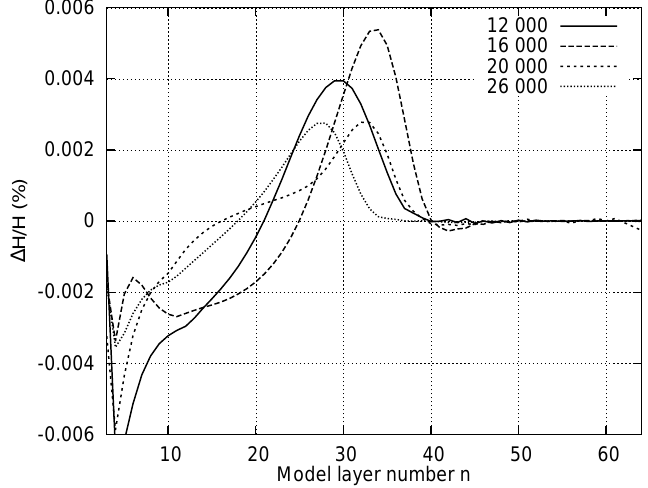
Fig. 4. The final high-precision constancy of the model stellar atmosphere flux (in %), obtained computing the Jacobian by Levenberg-Marquardt method and thereafter improving it by iterations of the Broyden loop. In the models log g = 4 and in the legend – the effective temperatures.